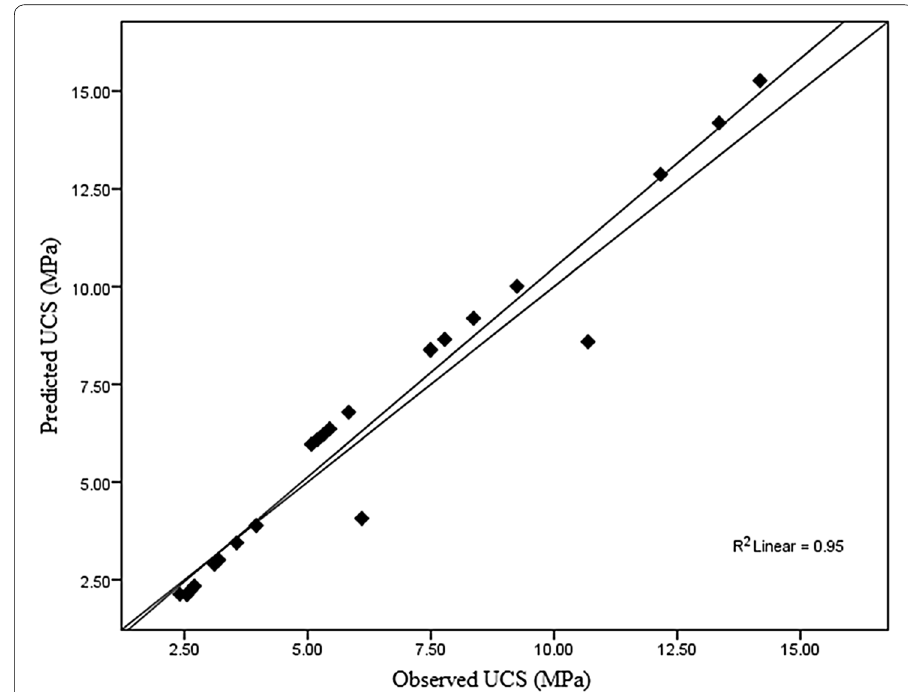
Fig. 5 Cross-correlation of predicted and observed values of UCS for ANN